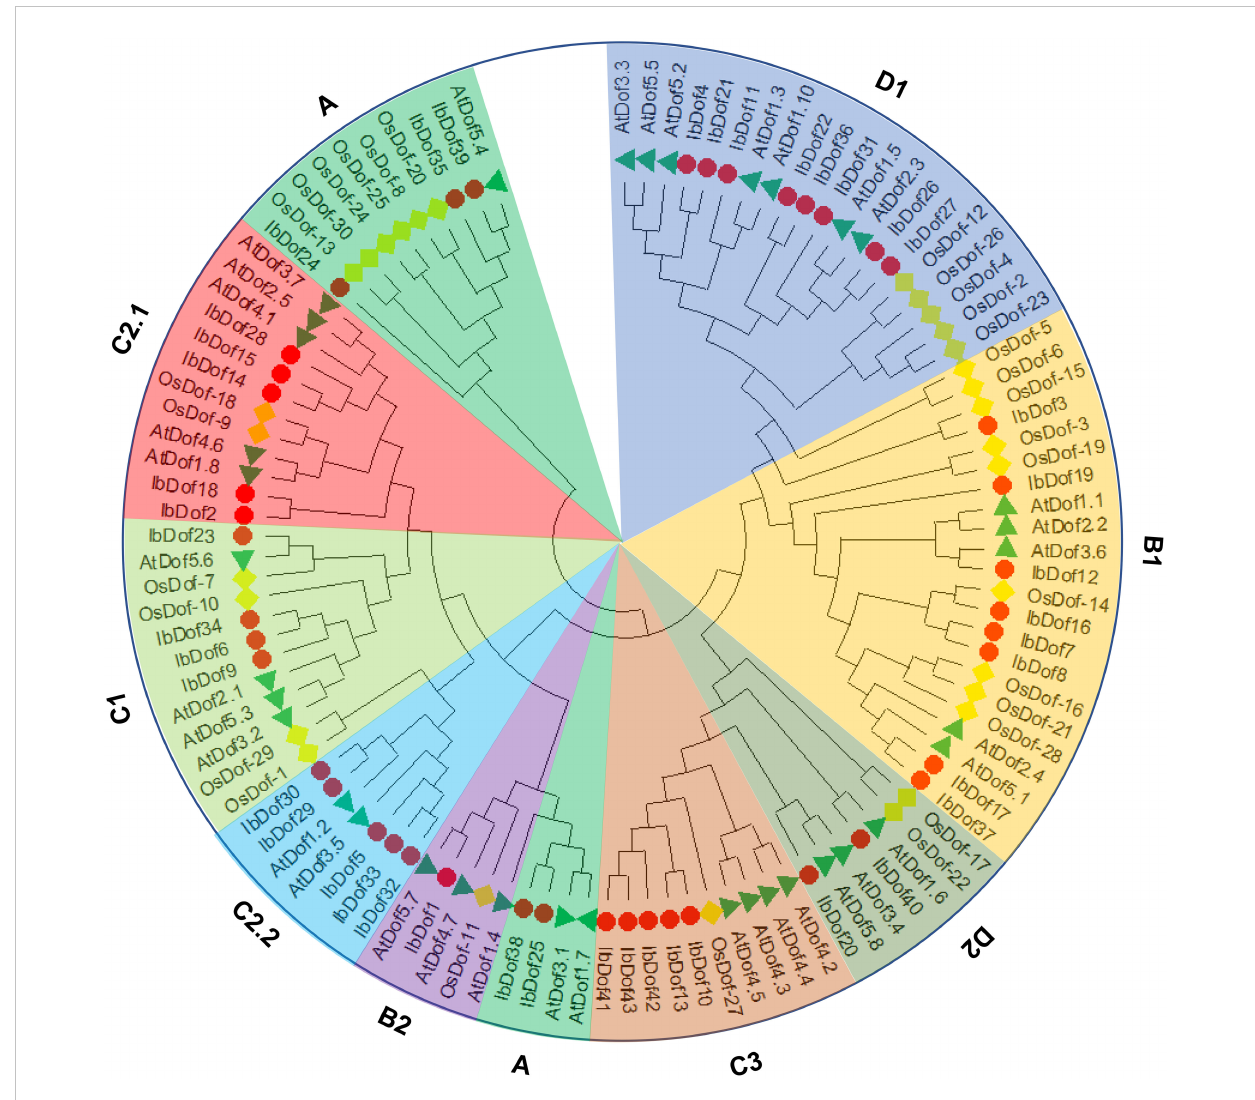
FIGURE 2 Unrooted phylogenetic tree constructed with sweetpotato IbDofs, Arabidopsis AtDofs and rice OsDofs. All the protein sequences were aligned by ClustalW and the phylogenetic relationships were derived through the Maximum Likelihood method, the best evolutionary model JTT + G + I + F calculated through MEGA X was selected with the bootstrap value of 1000. Different subgroups are named based on the reports in Arabidopsis and rice and are distinguished with different colors. The protein names are marked at the end of the branch, the red circle, green triangle and blue rhombus represent the sweetpotato IbDofs, Arabidopsis AtDofs, and rice OsDofs,